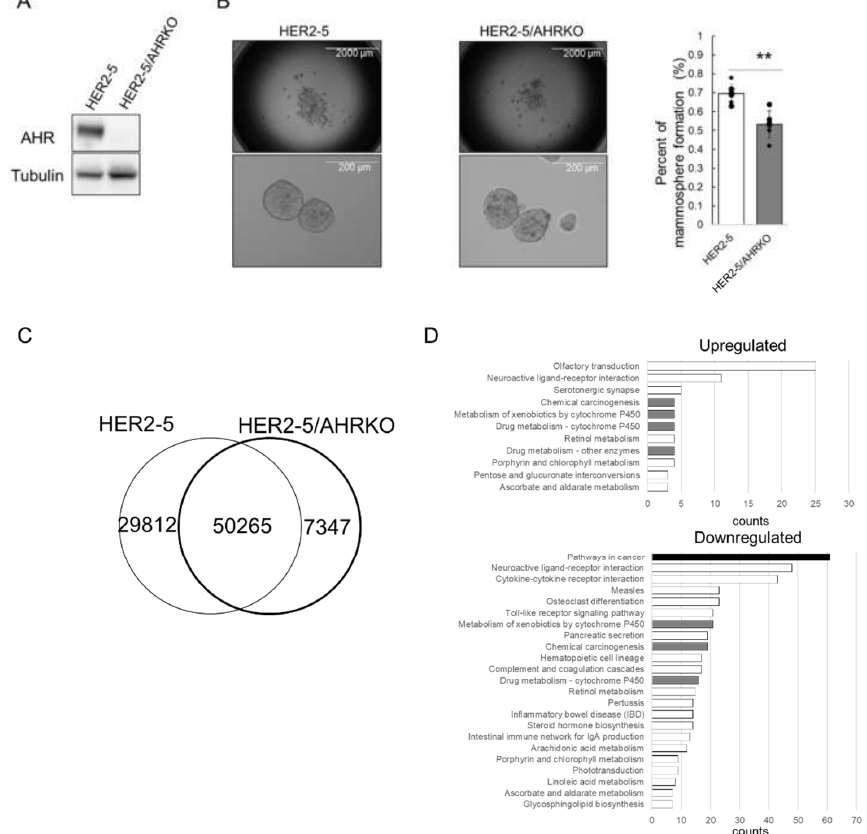
Figure 1. Difference in mammosphere formation efficiency and accessible chromatin regions between HER2-5 and HER2-5/AHRKO cells. ( A ) Whole-cell lysates (10 µg) were resolved by sodium dodecyl sulfate-polyacrylamide gel electrophoresis, and proteins were detected by immunoblot analysis using antibodies against AHR and α-tubulin. ( B ) HER2-5 cells and HER2-5/AHRKO cells were cultured under non-adherent conditions for 7 days. The mammospheres were observed under a light microscope with 2× magnification (scale bar is 2000 µm) and 20× magnification (scale bar is 200 µm). The percentage of cells contributing to mammosphere formation was calculated as the number of spheres divided by the original number of seeded cells [22]. Each column represents the mean of six wells. The depicted results are representative of two independent biological experiments. ** p < 0.01 (Student’s t test). ( C ) ATAC-seq was performed using HER2-5 cells and HER2-5/AHRKO cells. The overlap peaks are presented in a VENN diagram. The diagram shows the number of merged regions that contain peaks from the samples in each of the overlapping categories. ( D ) Upregulated and downregulated GO terms for biological processes enriched among differentially expressed genes were annotated using the DAVID